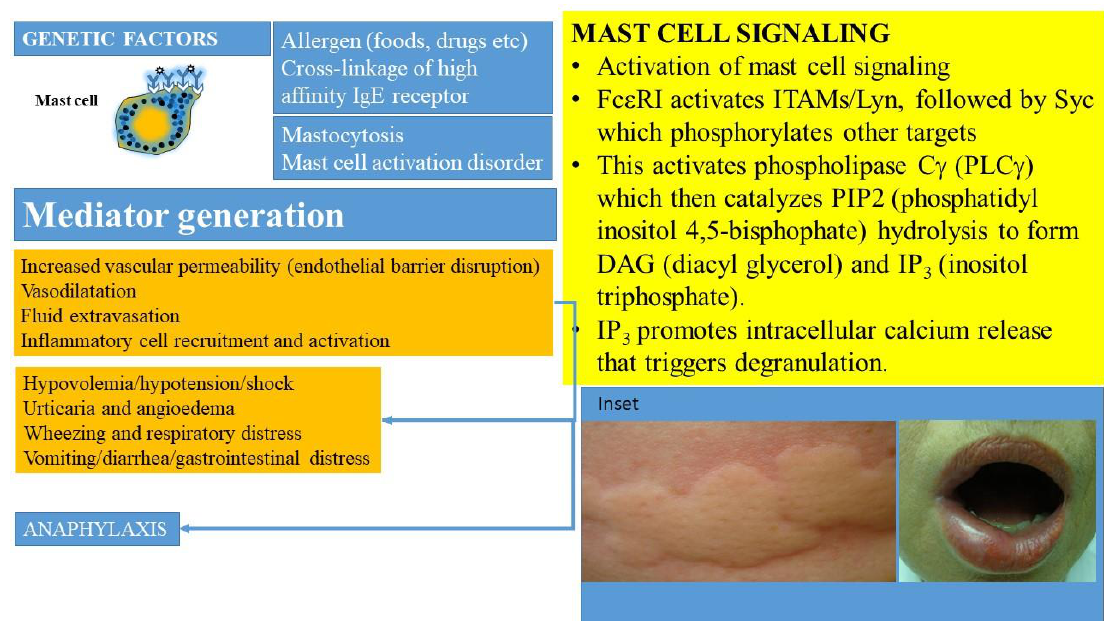
Figure 1. Activation of MCs occurs when allergen specific IgE is bound by the allergen and interacts with the high affinity receptor for immunoglobulin (IgE), referred to as FcεRI, carried on their surfaces in the presence of mutations and other molecular-genetic defects. This culminates in the release of preformed and newly synthesized mediators from mast cells and basophils that sets off a sequence of inflammatory events manifesting clinically as anaphylaxis and leading to shock. MC-derived cytokines, histamine, leukotrienes, prostanoids, and PAF regulate vascular instability and barrier dysfunction of endothelial cells and contribute to edema formation. Hypovolemia, angioedema, hypotension, and cardiorespiratory failure ensue. Inset shows examples of urticaria and angioedema.